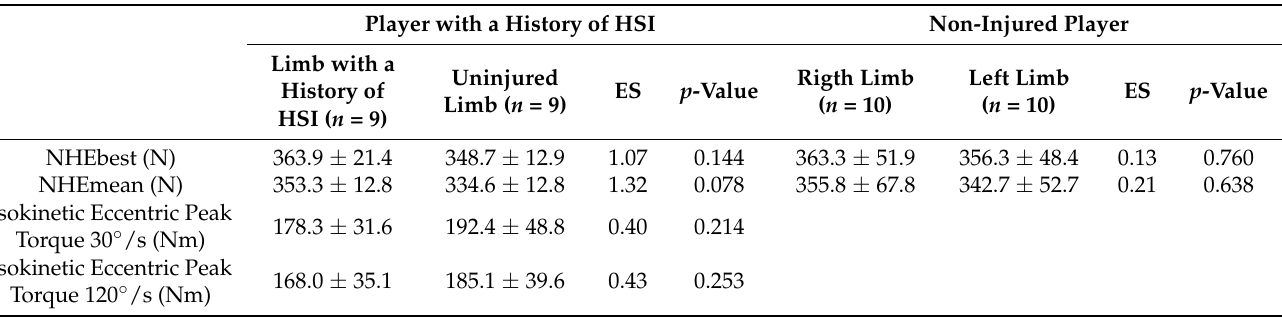
Table 2. Comparative knee flexor eccentric strength between the injured and non-injured players. Data are presented as mean ± SD. Player with a History of HSI Non-Injured Player Limb with a